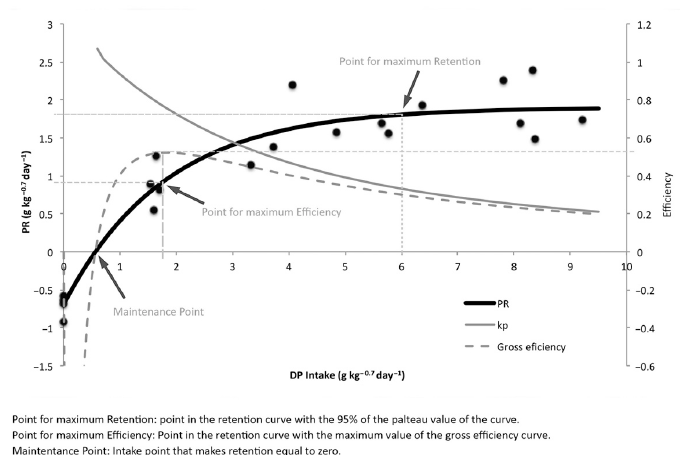
Figure 2. Effect of digestible protein intake (g kg − 0.7 day − 1 ) on protein retention (g kg − 0.7 day − 1 ).